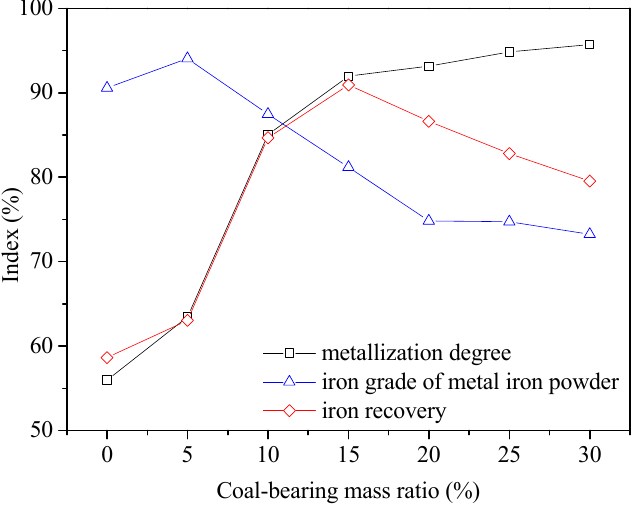
Figure 7. Effect of coal-bearing mass ratio on the reduction and separation indexes (reducing at 1300 °C for 20 min with a total C/Fe mass ratio of 1.0).